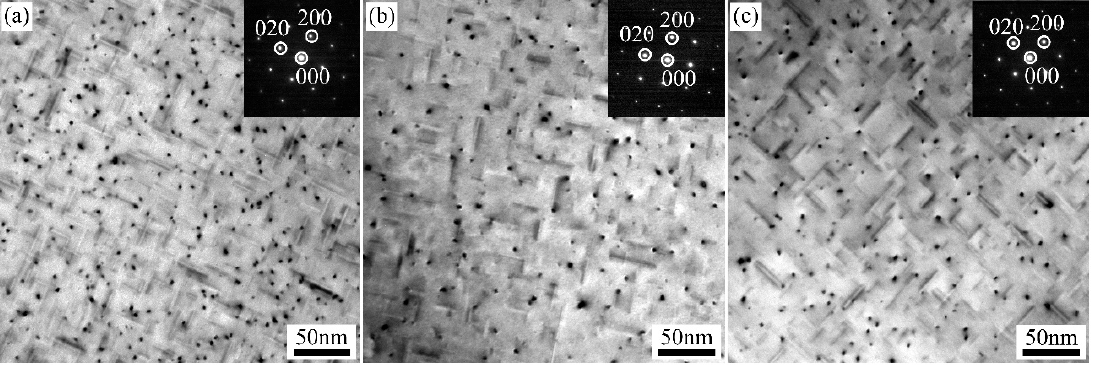
Figure 9. TEM bright field images of A1, A2, and A3 alloys after paint-bake hardening at 185 °C for 8 h: ( a ) A1 alloy, ( b ) A2 alloy, and ( c ) A3 alloy. Table 2. The statistics of β″ precipitates in A1, A2, and A3 alloys after paint-bake hardening at 185 °C for 8 h.